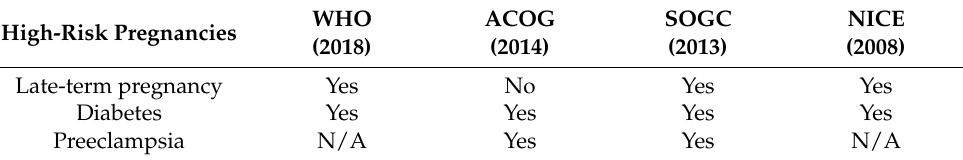
Table 1. Recommended use of misoprostol for induction of labor (IOL) across the guidelines. High-Risk